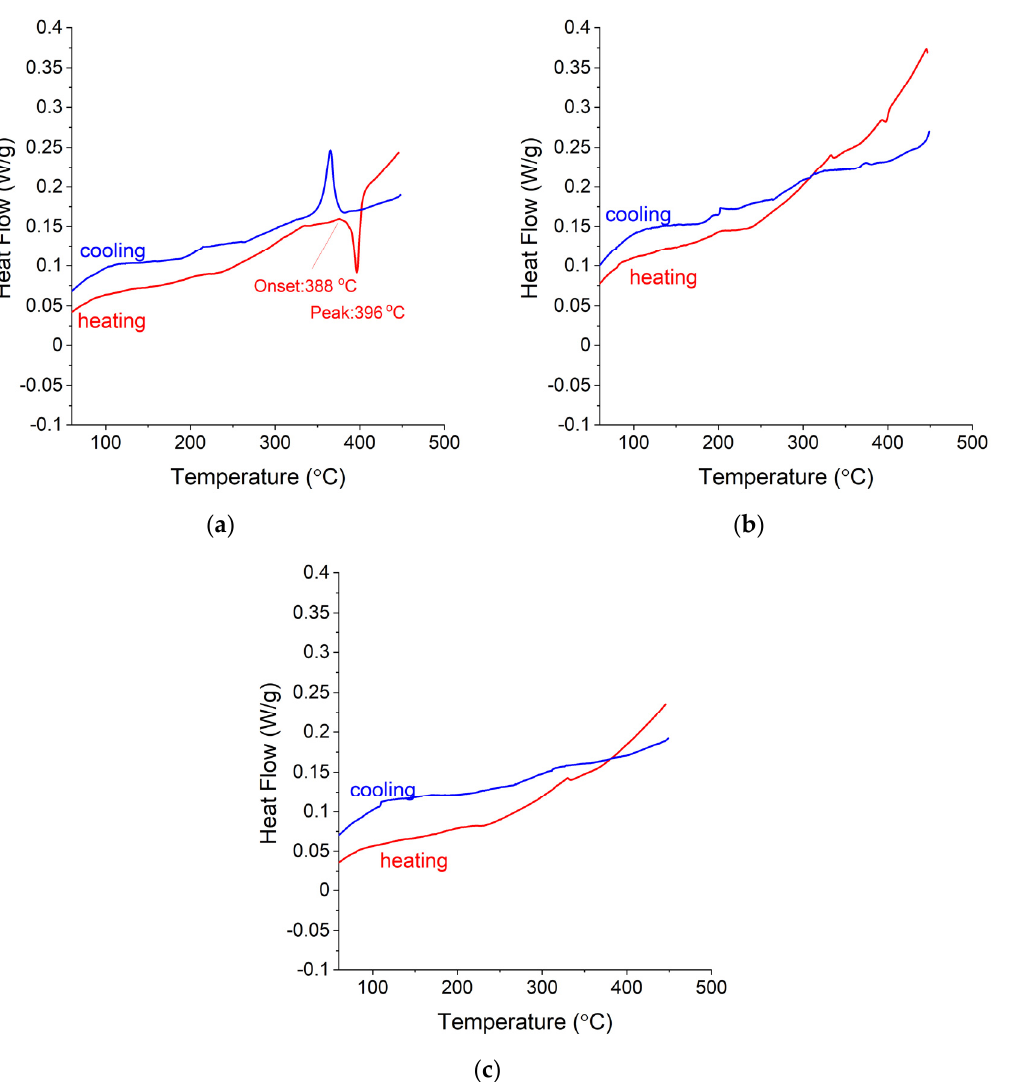
Figure 10. Differential scanning calorimetry profiles for ( a ) Alloy 10, ( b ) Alloy 9, and ( c ) Alloy 8. In contrast to the DSC plots shown for the three samples with the highest Ag concen- tration, the subsequent samples, with Mg concentrations higher than 50 at. %, show in addition, a transformation peak related to the decomposition temperature of the MgH 2 compound. Alloy 7 shows the lowest decomposition onset temperature, which equals 376 °C (Figure 11a), and the lowest H 2 quantity desorbed compared to the other samples (Fig- ure 12). As the Mg concentration in the Ag-Mg samples increases, the amount of hydrogen desorbed increases, reaching 6.48 wt. %. The mass percent of desorbed hydrogen for this sample is approximately 0.5% higher than that for pure Mg. This is obviously not coherent with the theoretical capacity and is very likely only the result of the incomplete hydro- genation of pure magnesium.